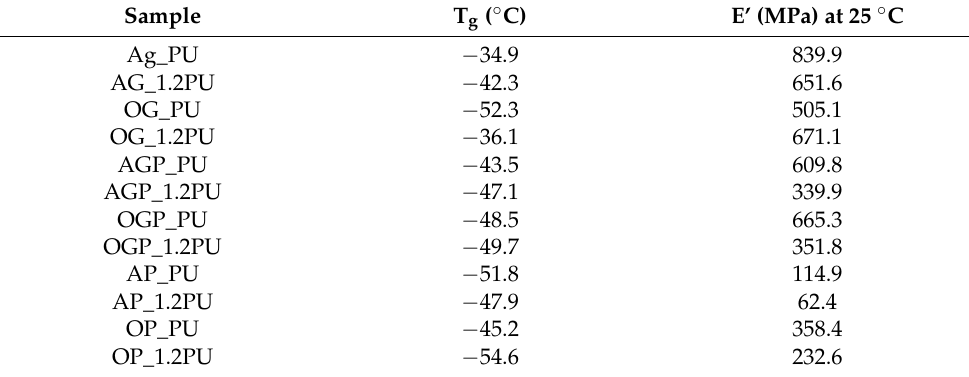
Table 3. Dynamic mechanical and thermal properties of polyurethane resins [94].